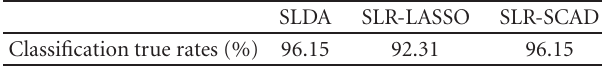
Table 6: List of classification true rates. SLDA SLR-LASSO SLR-SCAD Classification true rates (%) 96.15